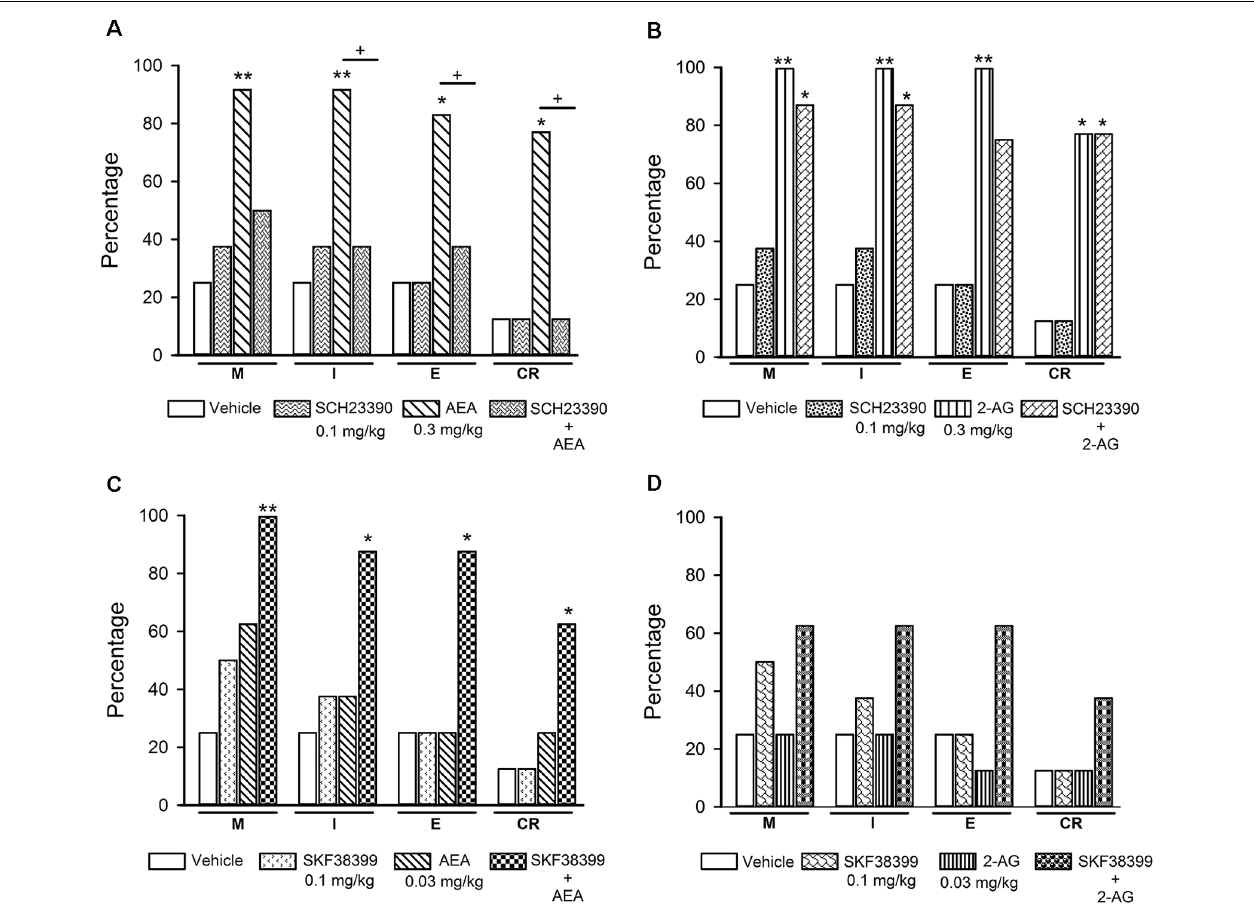
FIGURE 7 | Effects of the combined treatment of eCBs and D1-like receptor ligands on sexual behavior of sexually exhausted male rats. The upper graphs show the percentages of sexually satiated rats that are able to mount (M), intromit (I), ejaculate (E) and resume copulation after ejaculation (CR) following vehicle (1 ml/kg), the D1-like receptor antagonist SCH23390 (0.1 mg/kg), AEA (0.3 mg/kg) or 2-AG (0.3 mg/kg) and the combined treatment of SCH23390 with AEA (panel A ) or with 2-AG (panel B ). The lower graphs depict the effects of vehicle (1 ml/kg), the D1-like receptor agonist SKF38399 (0.1 mg/kg) and their combined treatment with AEA (0.03 mg/kg; panel C ) or 2-AG (0.03 mg/kg; panel D ) on the percentages of satiated rats showing M, I, E and CR. Fisher F test, ∗ P < 0.05, ∗∗ P < 0.01, + P < 0.05; n = 8 for each group. Asterisks over bars indicate statistical significance vs. the control group; crosses show significance for other indicated